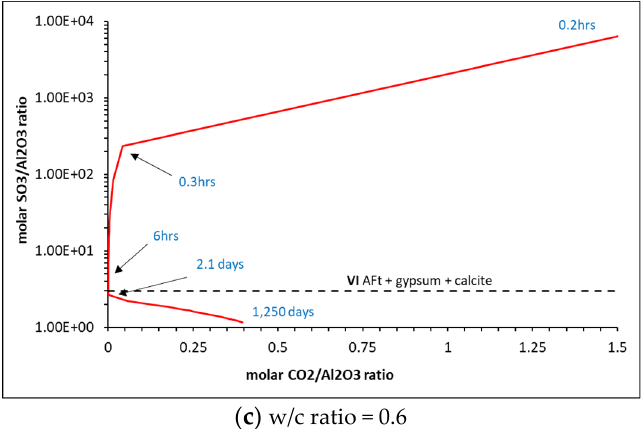
Figure 11. Change in sulfate and carbonate ratios during 1250 days of hydration.